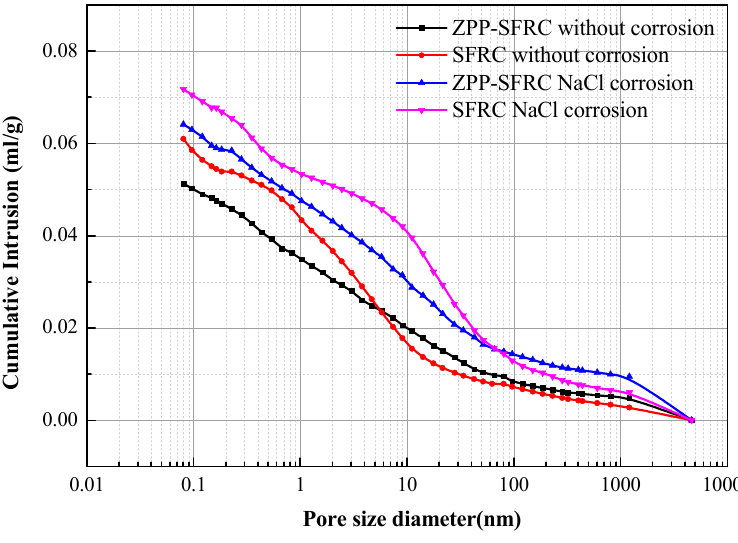
Figure 7. Mercury intrusion of ZPP-SFRC and SFRC.